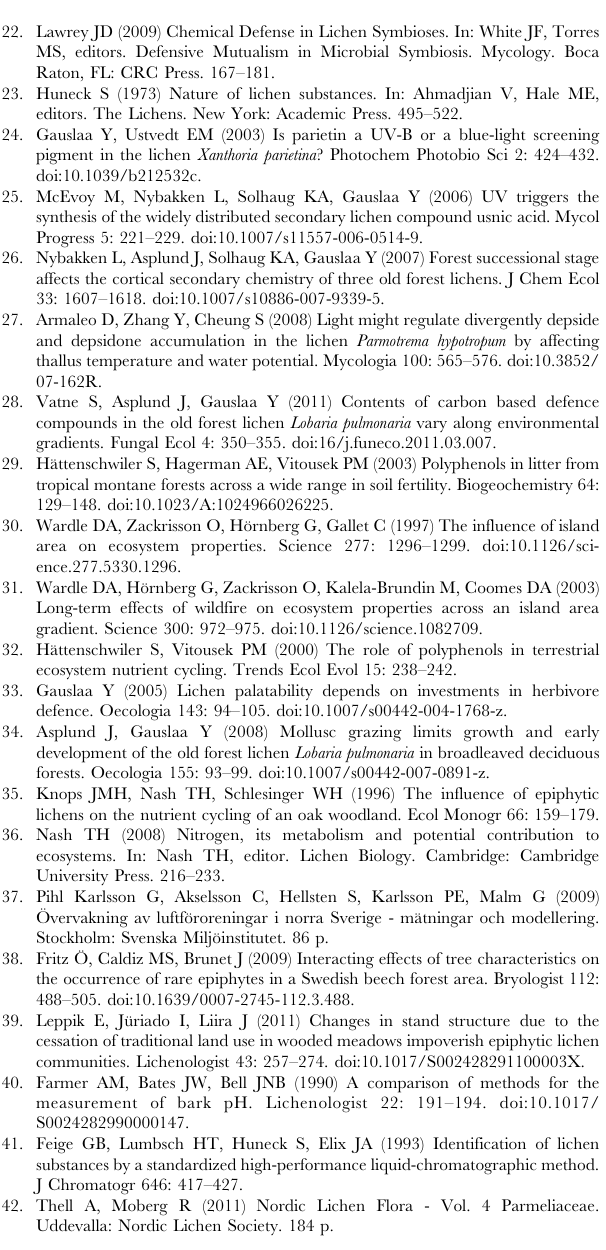
Table S1 Changes in selected ecosystem properties and traits of the host plant ( Betula pubescens ) across the island size